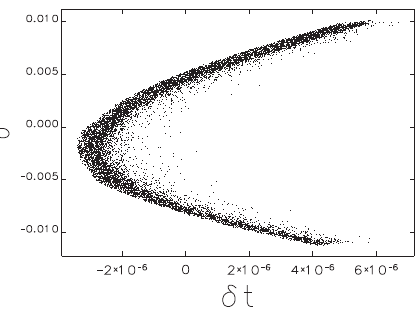
FIG. 7. Example of curvature in the longitudinal phase space induced on a compressed bunch from rf curvature and non- linearity of the transport lattice. Here δ and δ t are normalized values of momentum and time,